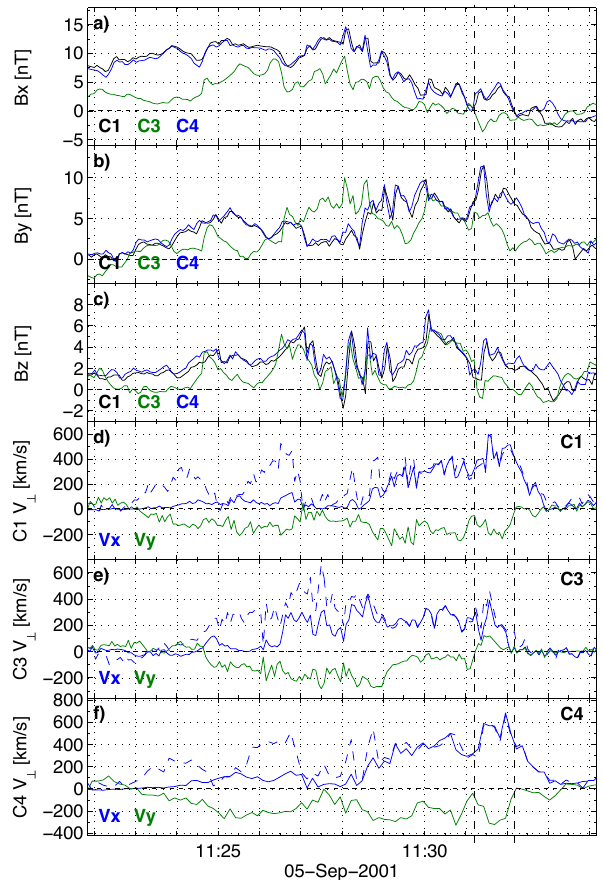
Figure 6. Cluster data on 5 September 2001 at 11:22–11:34UT. (a – c) Magnetic field components measured by the C1 (black line), C3 (green line) and C4 (blue line) spacecraft. (d – e) X and Y compo- nents of the ion bulk velocity for C1 and C3 from the HIA detector. (f) X and Y components of the proton bulk velocity for C4 from the CODIF detector. The dashed and solid lines mark the components of the total velocity and the velocity perpendicular to the magnetic field, respectively. The first vertical dashed line indicates the V ⊥ y reversal associated with the B x sign change at C3. The second ver- tical dashed line indicates the V ⊥ y reversal associated with the first B x sign change at C1 and C4.